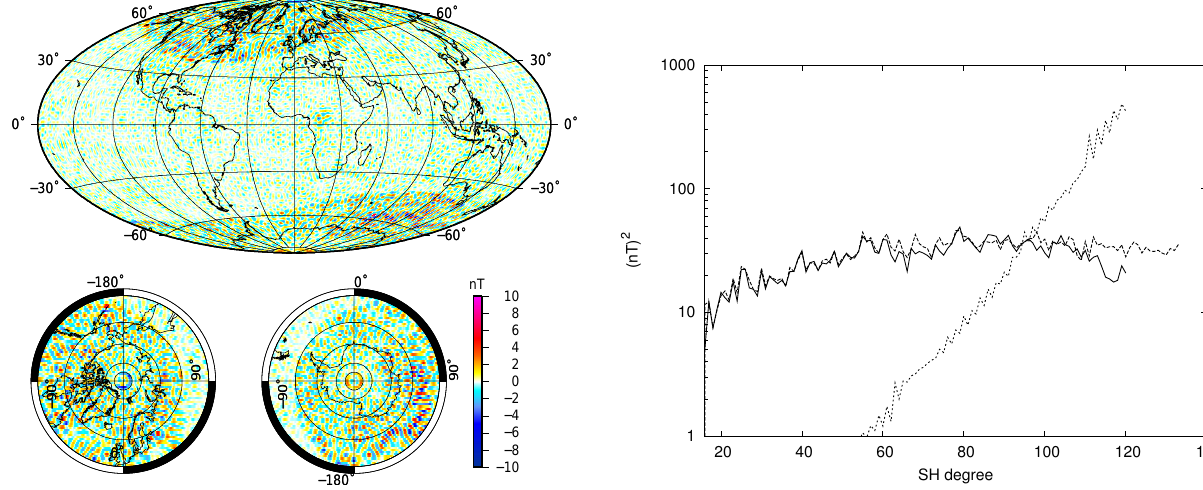
Fig. 6. Left: Residuals map to the final model fit to (noisy) lithospheric field ˆ B i at r = 6671 . 2km. Residuals have been scaled by a factor 10. At mid-latitudes the largest residuals are associated with the strong magnetic anomalies. The along-track noise has been fitted by the noise model and therefore does not appear in these residuals. Right: Power spectra of the lithospheric field model B i (solid line), of MF7 (dashed line), and the noise model (dotted line) calculated at the Earth’s surface (i.e. r = 6371 . 2km radius).